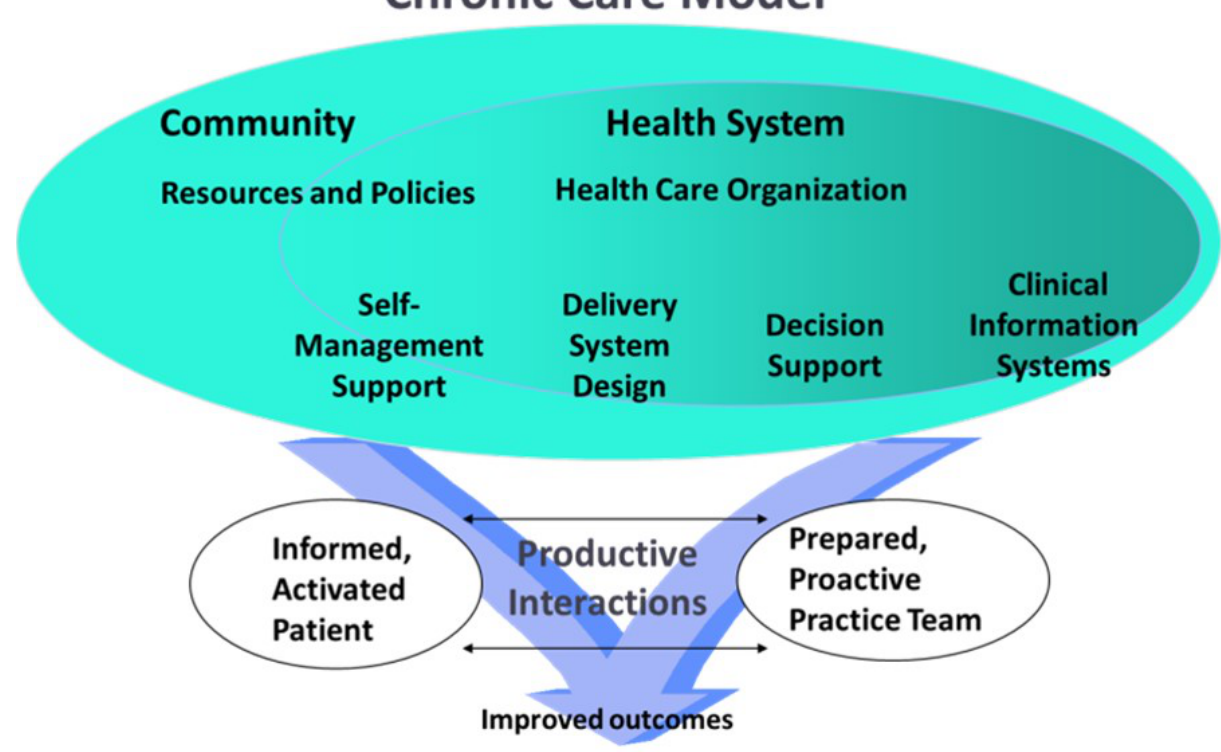
Figure 1. The Chronic Care Model. Developed by the MacColl Institute, ©ACP-JSIM Journals and Books, reprinted with permission from ACP-ASIM Journals and